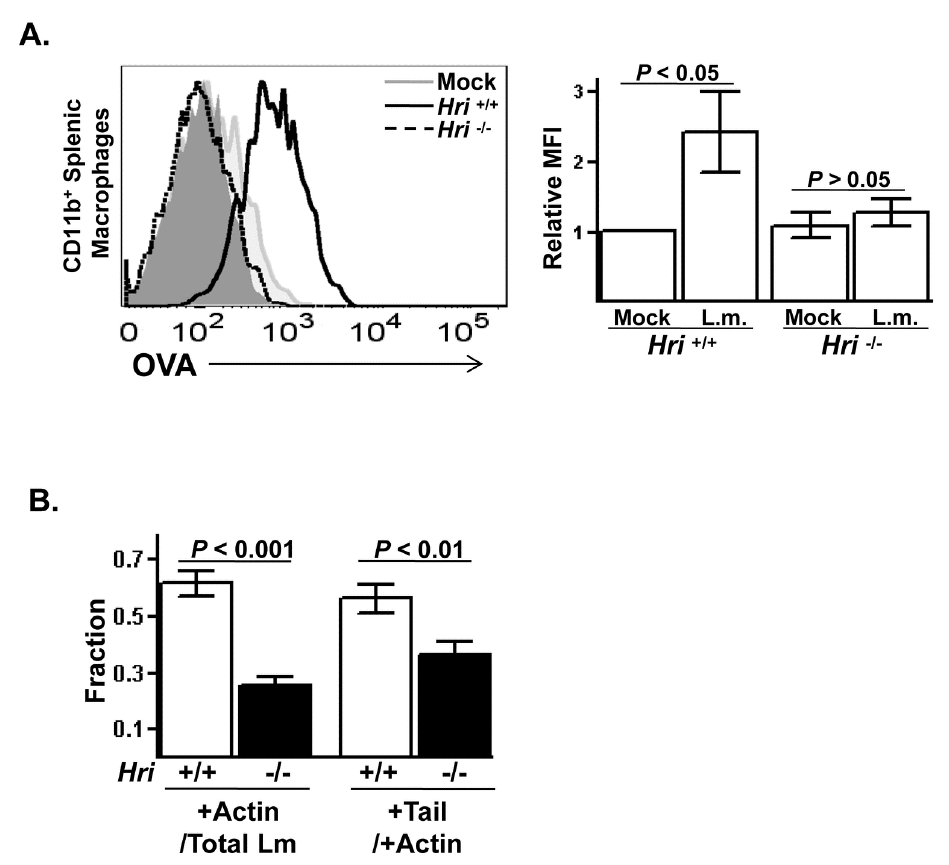
Figure 5. Absence of HRI reduces the translocation of Listeria into the cytosol. ( A ) Single-cell suspensions of splenocytes were prepared from Hri +/+ and -/- mice and either left uninfected or infected in vitro for 5 hrs with OVA-expressing L. monocytogenes . Histogram displays the levels of OVA surface staining on viable CD11b + -gated macrophages from a representative experiment and the relative median fluorescence intensities (MFI) of 3 separate experiments is shown in the right panel. The isotype control stained cells are shown in the grey filled plot. ( B ) Unstimulated peritoneal macrophages isolated from Hri +/+ and -/- mice were infected in vitro with GFP-expressing L. monocytogenes for 6 hr and then stained for actin. The fraction of L. monocytogenes (Lm) that were actin associated was determined by dividing the yellow and red-tailed green Lm by the total Lm ( Hri +/+: N=418 Lm/168 macrophages; Hri -/-: N=542 Lm/167 macrophages). The fraction of cytosolic Lm that possessed actin tails was determined by dividing the red-tailed green Lm by the total number of yellow and red-tailed green Lm. ( P values calculated using student t